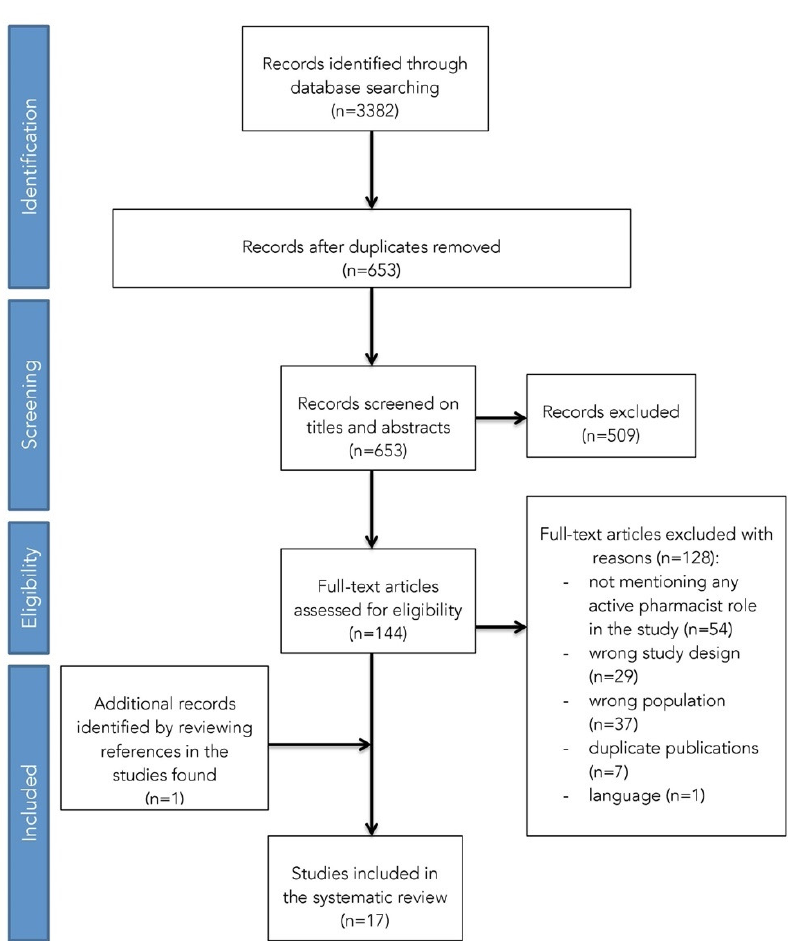
Figure 1. Study selection process using the PRISMA flowchart.